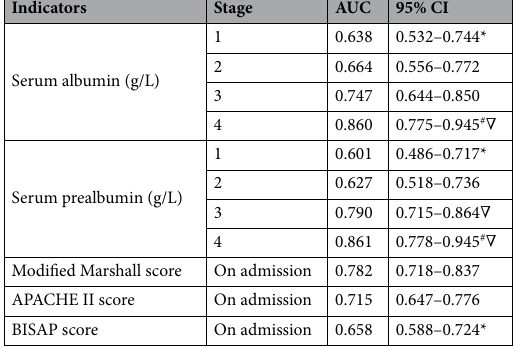
Table 6. Comparison of ROC curves for survival in SAP. *P < 0.05 compared with Modified Marshall score. # P < 0.05 compared with APACHE II score. ∇ P < 0.05 compared with BISAP score.